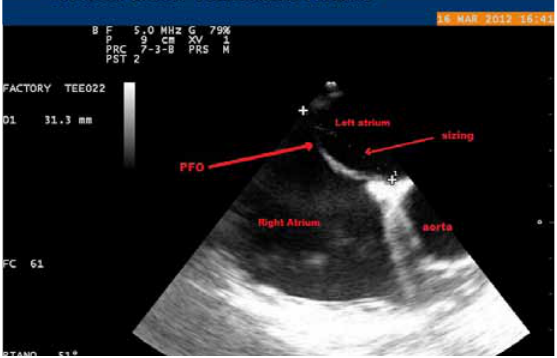
Figure 4. Patients on follow up (37 patients in